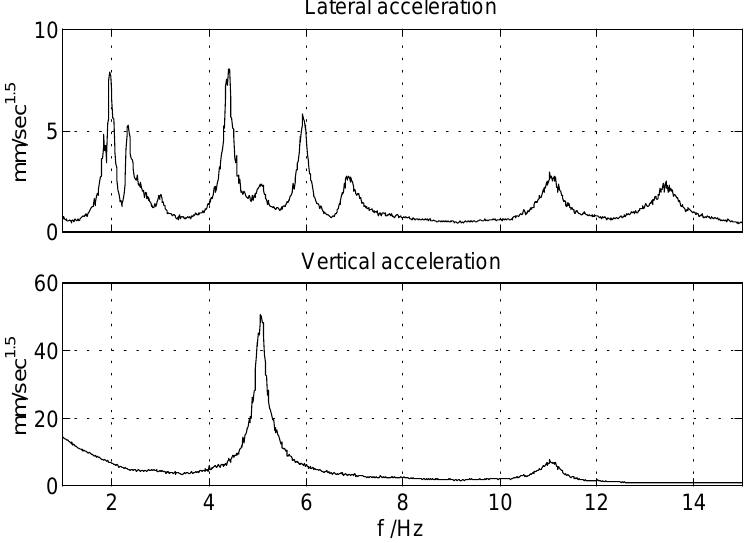
Fig. 3. Square root auto-spectral density of lateral (upper) and vertical (lower) acceleration response mainly due to heavy pedestrian